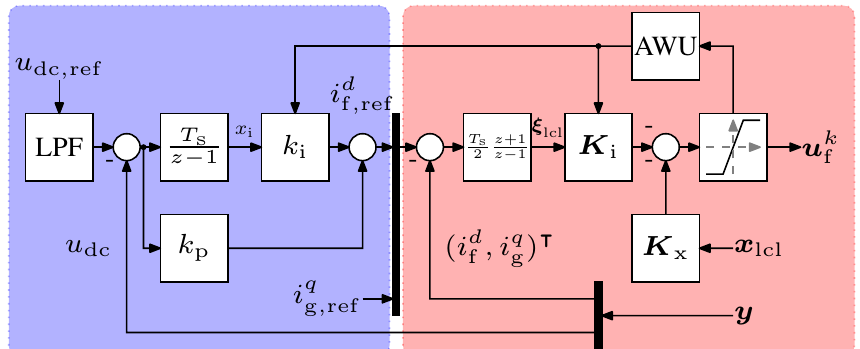
Figure 5. Cascaded structure of proposed controllers. dc-link voltage PI controller with filtered reference (blue) and the underlying state feedback current controller